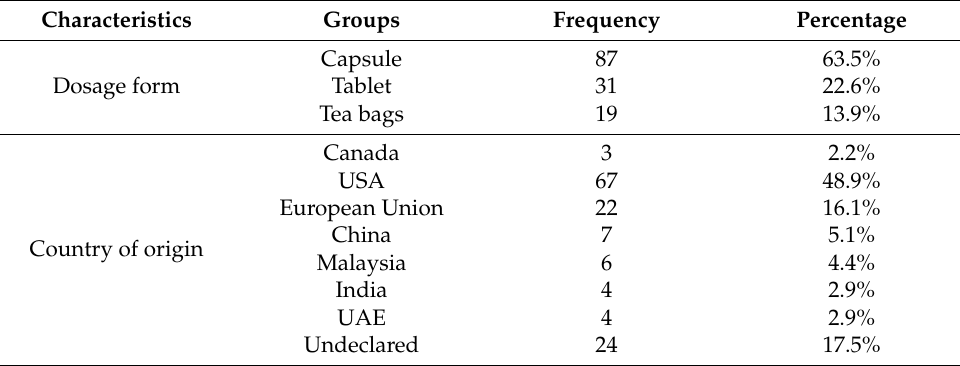
Table 1. Number and percentages of sample baseline characteristics ( n = 137).